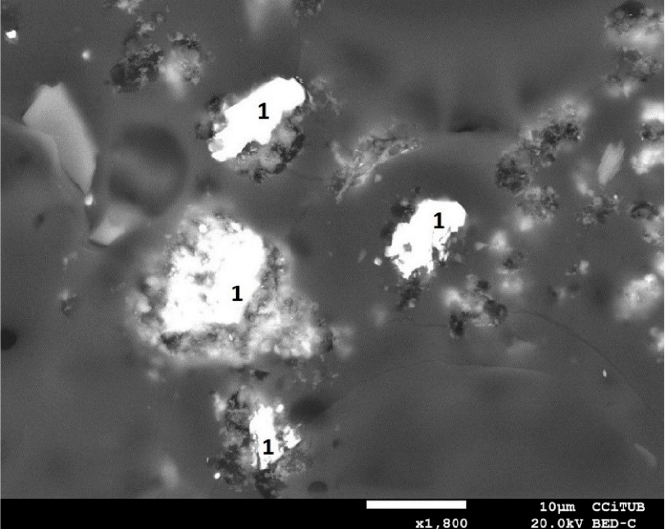
Figure 18. SEM image of the leaching residue from the test at 70 °C with pretreatment. CuFeS 2 identified with (1).